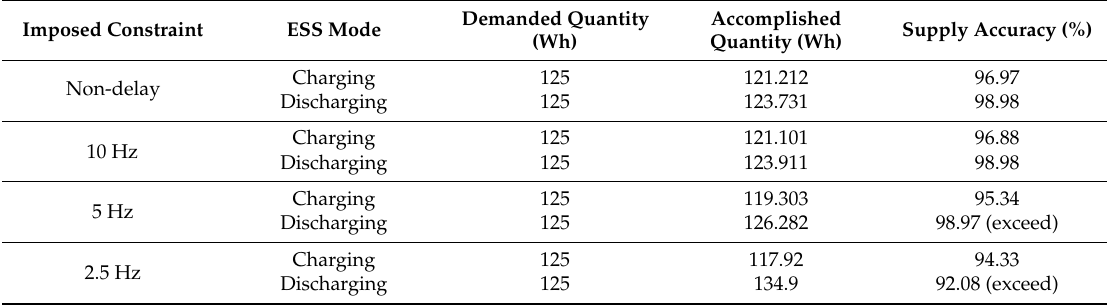
Table 4. Comparison data for designed simulation.